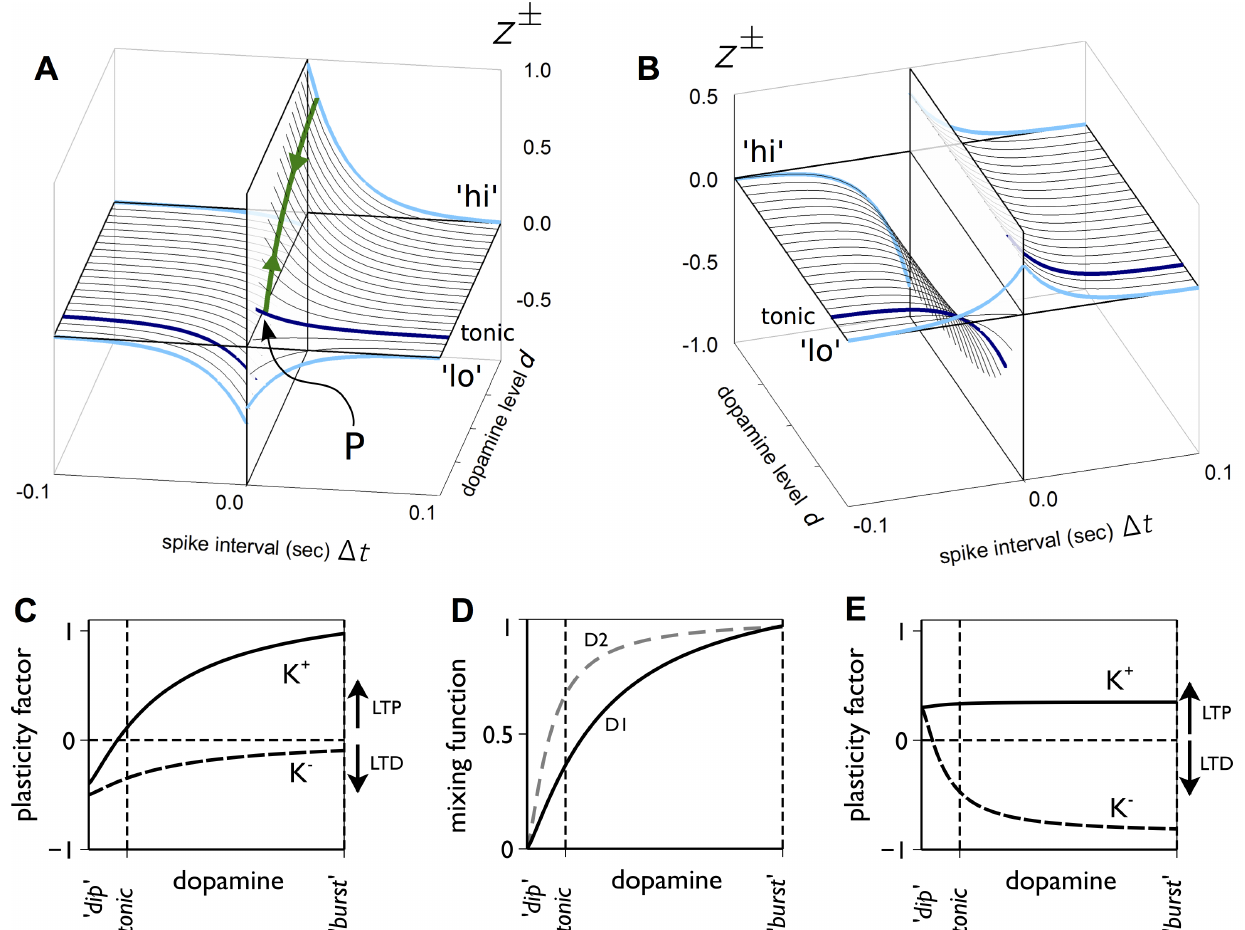
Figure 5. The ‘‘function mixing’’ model of dopamine-dependent cortico-striatal plasticity. The 3D plots in (A and B) are for D1 and D2 MSNs, respectively. In these plots, for constant levels of dopamine d , the thick, light-blue lines show the STDP functions z + ( D t ), z + ( D t ) at high and lo hi low dopamine levels corresponding to those in Figure 4. For other (constant) values of d , the STDP function z ( d , D t ) is obtained by smoothly ‘‘blending’’ together z z ( D t ), z z ( D t ) for positive timing, and z { ( D t ), z { ( D t ) for negative timing. Thinner black lines show some examples of this, and lo hi lo hi the tonic dopamine level in our model gives functions shown in dark blue. With time-dependent levels of dopamine and eligibility, the generalised plasticity function z ( d ( t ), D t ) can change dynamically with time for a given D t . The green line in (A) shows a typical such trajectory as a phasic dopamine burst is received, starting at tonic level, moving to the peak of phasic amplitude and back again. (D) The mixing function a ( d ) that determines how much of each of the functions, z + ( D t ), z + ( D t ) are blended together across the range of dopamine d . (C and E) The resultant lo hi plasticity factors for D1 (C) and D2 (E) MSNs, respectively, giving the amplitude of the STDP functions at D t ~ 0 in (A) and